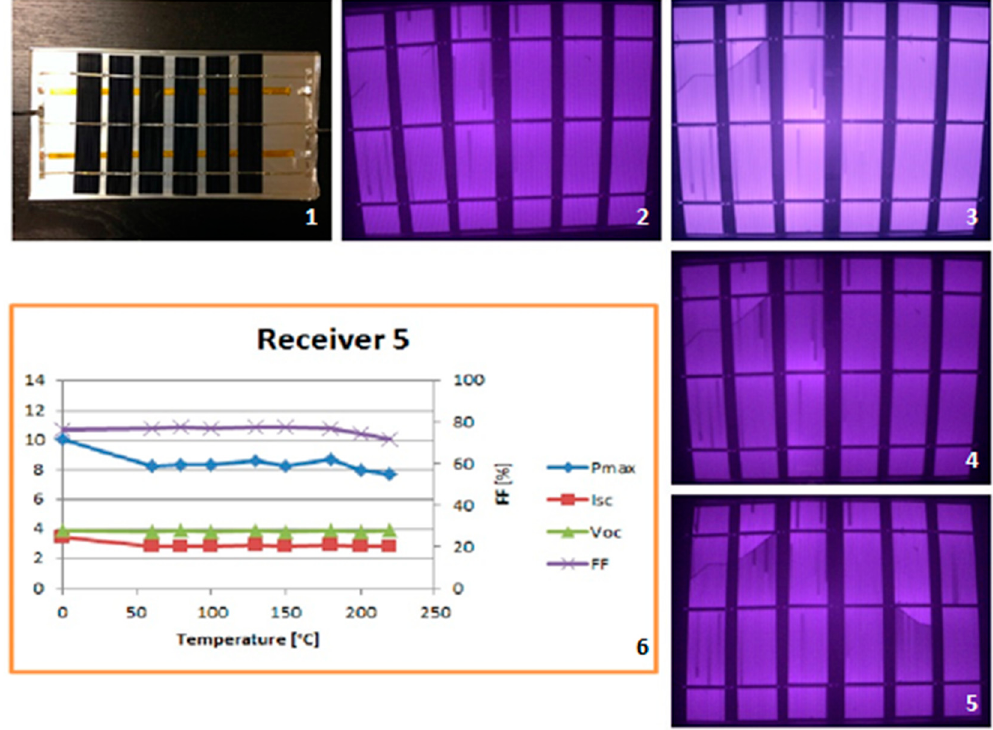
Figure 13. ( 1 ) Receiver 5; ( 2 ) Baseline Round; ( 3 ) Round 5 (150 °C); ( 4 ) Round 6 (180 °C); ( 5 ) Round 8 (220 °C); ( 6 ) Parameters of the IV curve at different temperatures (Isc, Voc and Pmax shown in the left Y axis and FF in the right Y axis).